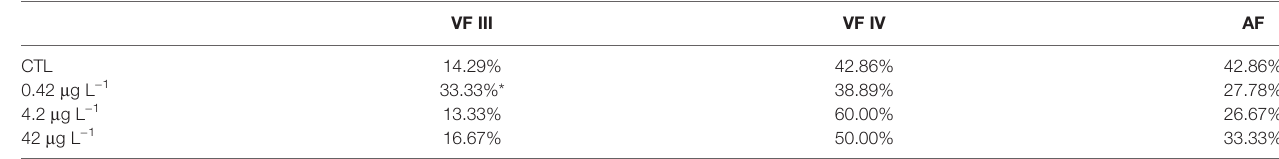
Asterisk superscript (*) indicates signi fi cant differences between control group (CTL) and DiNP treatments (glm test, *p <